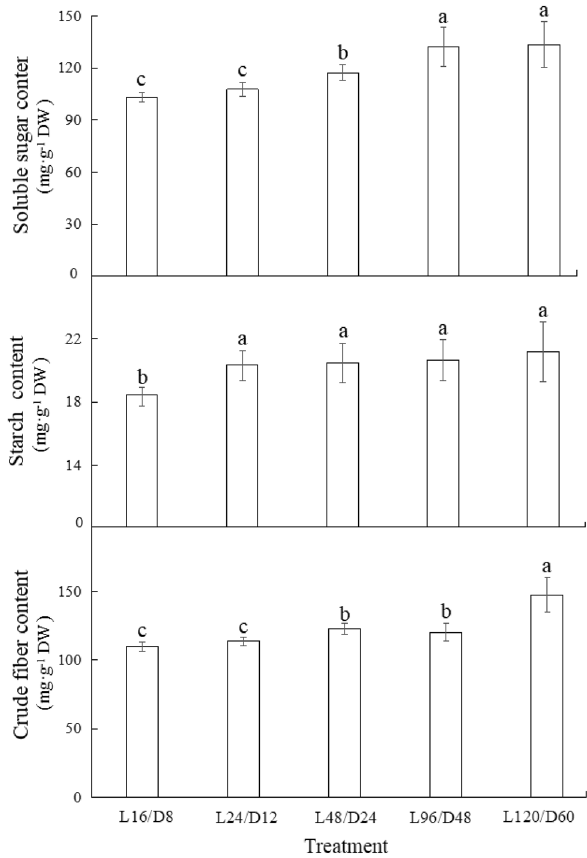
Figure 7. The contents of soluble sugar, starch and crude fiber of lettuce exposed to different L/D cycle treatments of RB. Different letters for the same parameter indicate significant differences at the 5% level, according to the Tukey’s test (n = 3). The bars represent the standard errors. L/D—light/dark. L16/D8—16 h light/8 h dark (as control), L24/D12—24 h light/12 h dark, L48/D24—48 h light/24 h dark, L96/D48—96 h light/48 h dark, L120/D60—120 h light/60 h